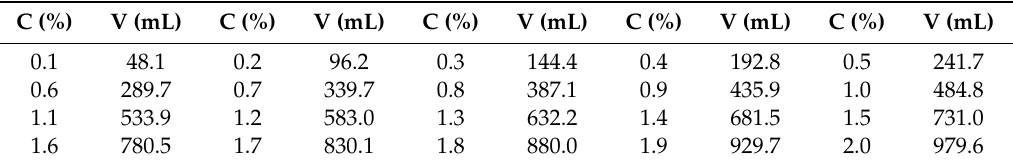
Figure 9. Photo of the air-tight chamber. Table 2. The calculated CH 4 concentration values and volumes for